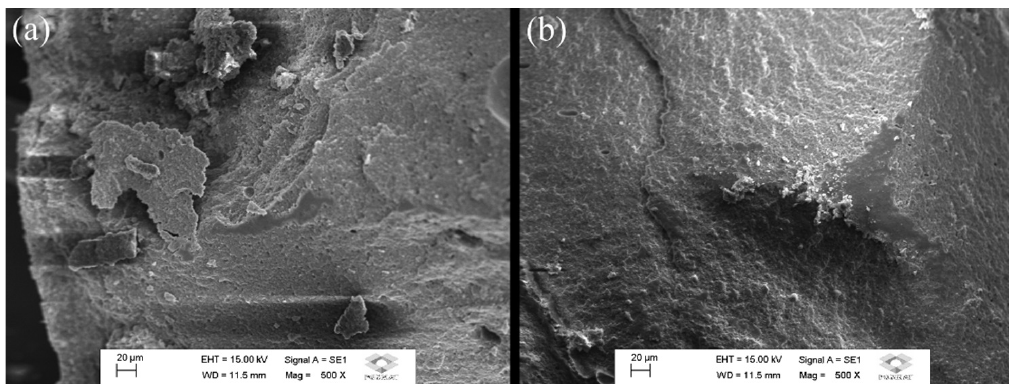
Figure 6. SEM images for P-Halogen (a) and P-LED